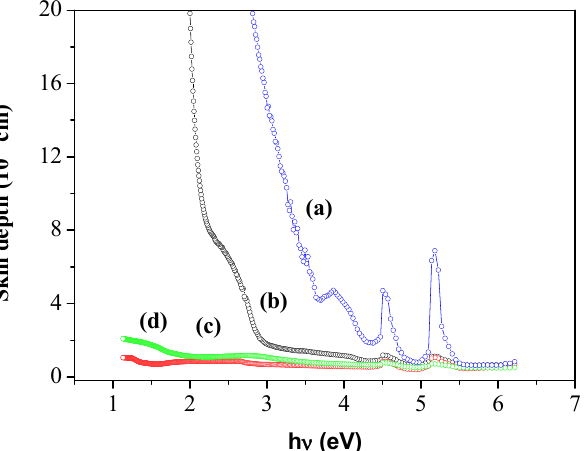
Figure 19. Skin depths of doped PANI: not annealed ( a ) and annealed ( b ); skin depths of doped PANI functionalized with CNTs: not annealed ( c ) and annealed ( d ).